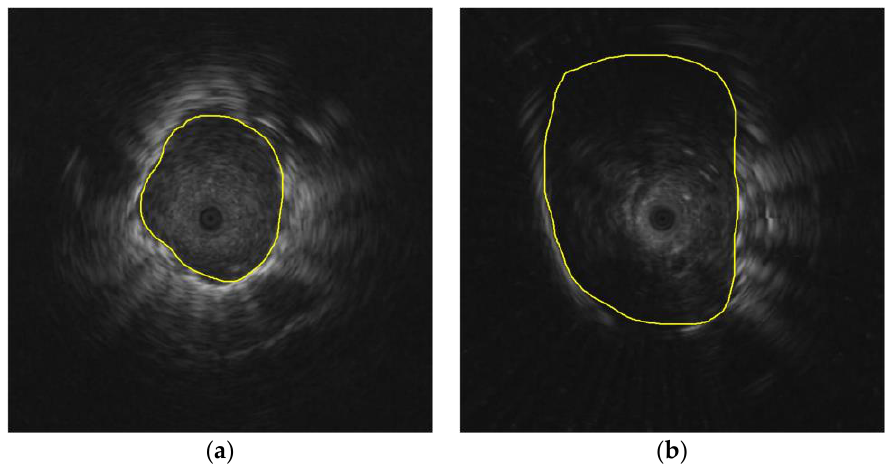
Figure 14. Misclassification of the radiomics feature and patient data-based model: ( a ) malignant